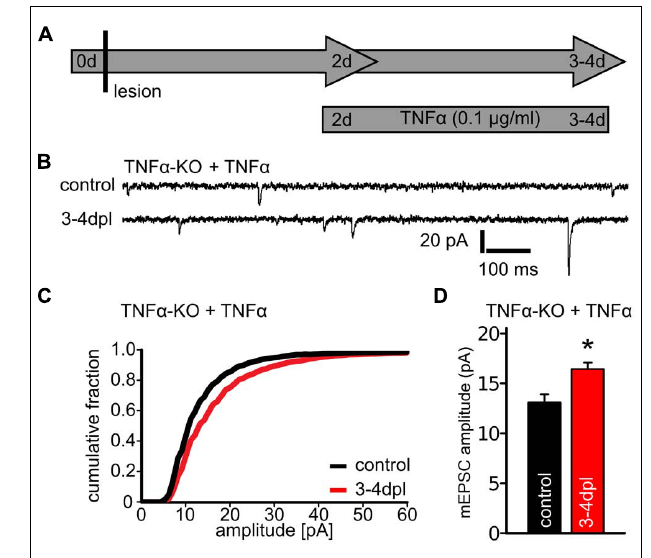
FIGURE 3 |Tumor necrosis factor alpha (TNF α )-treatment rescues the ability of denervated dentate granule cells to maintain increased excitatory synaptic strength at 3–4 dpl inTNF α -deficient slice cultures. (A) Schematic illustrating the experimental design. Denervated TNF α -deficient slice cultures were treated at 2 dpl withTNF α (0.1 μ g/ml) for 1 or 2 days and miniature excitatory postsynaptic currents (mEPSCs) were recorded (3–4 dpl). Age- and time-matched control cultures were not denervated but treated with the same concentration ofTNF α for 1